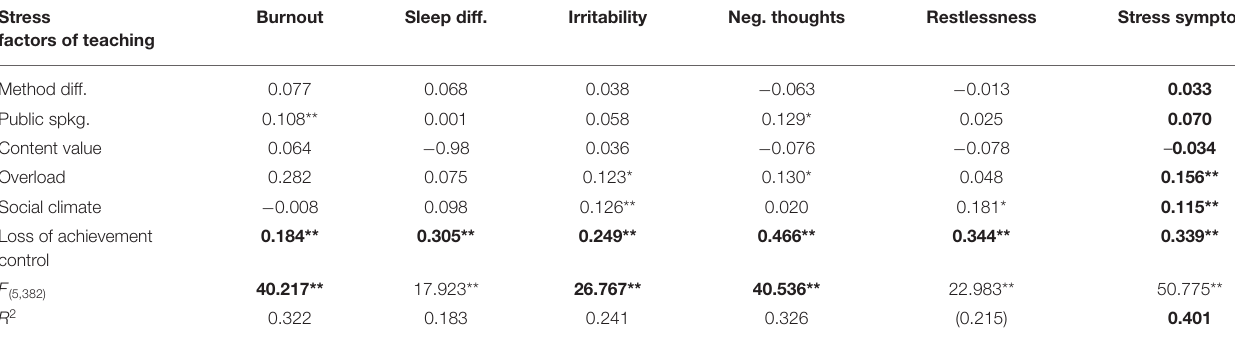
Stress symptoms